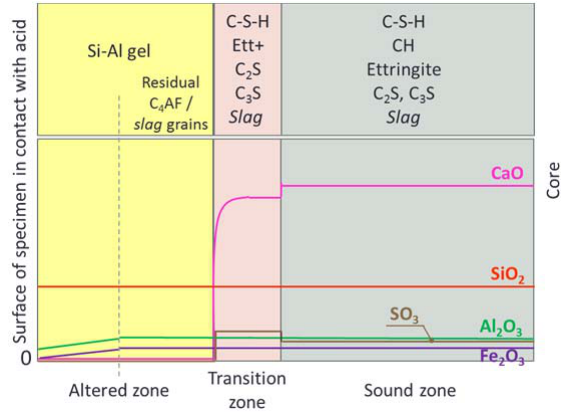
Figure 1. Typical mineralogical and chemical changes in CEM I / CEM III cement paste specimens (W/C=0.27) exposed to organic acid with soluble salts (e.g. acetic acid and other volatile fatty acids), for pH between 4 and 6 and concentration of acids of 0.3 mM. This diagram synthetizes data from EPMA, XRD and NMR 29 Si and 27 Al analyses [27,28,34]. Ett+: secondary, non ‐ harmful ettringite precipitated in transition zone. The thicknesses of the altered and transition zones are typically 2000  m and 200  m,